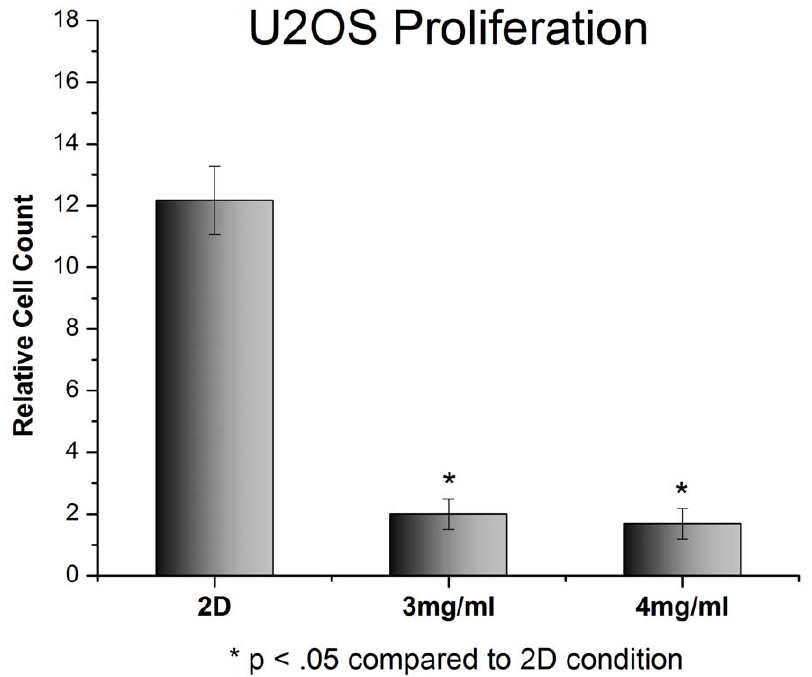
Figure 4. Proliferation of U2OS on standard 2D tissue culture plastic compared to 3D collagen gels. Cells were plated and immediately imaged. 96 hours later the cells were imaged again and the cell population was compared to the initial numbers. Cells in 3D show a dramatic reduction in proliferation, with approximately 1 cell division occurring over the 96 h experiment. Cells in 2D showed much more aggressive growth, with cell doubling occurring every 24–30 hours. (p , .05 between 2D and 3D samples).